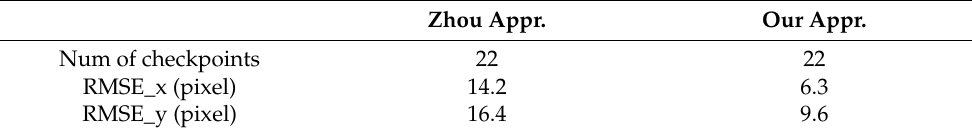
Table 2. Comparison results between Zhou’s method and our approach for a dataset of 22 checkpoints. Zhou Appr. Our